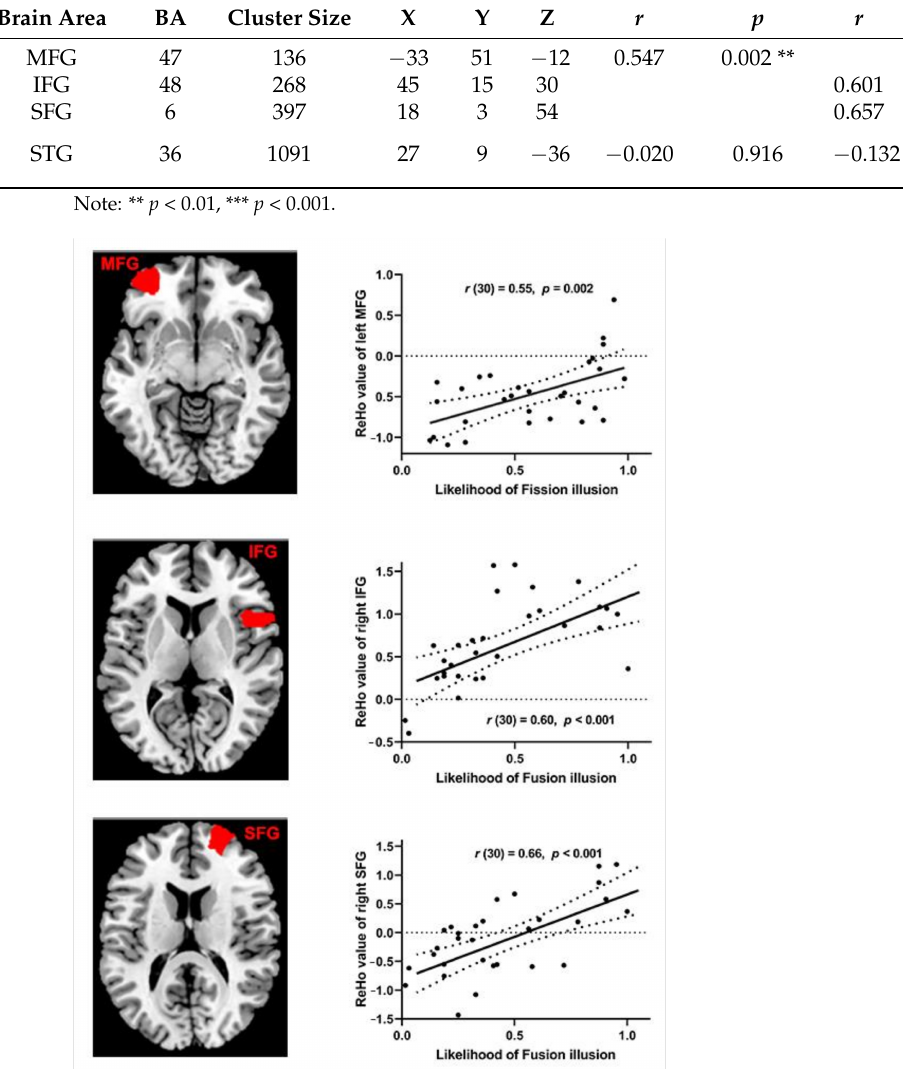
Figure 4. ( Left ). The older adults’ ReHo values and the likelihood of illusions showing a positive correlation in the left middle frontal gyrus (MFG), right inferior frontal gyrus (IFG) and right superior frontal gyrus (SFG). The red is the area where ReHo values are positively correlated with the likelihood of illusions. ( Right ). Scatter plot diagram shows the positive correlation between ReHo values of the left MFG and the likelihood of fission illusion of older adults, ReHo values of the right IFG and SFG and the likelihood of fusion illusion of older adults. Each point represents one participant’s